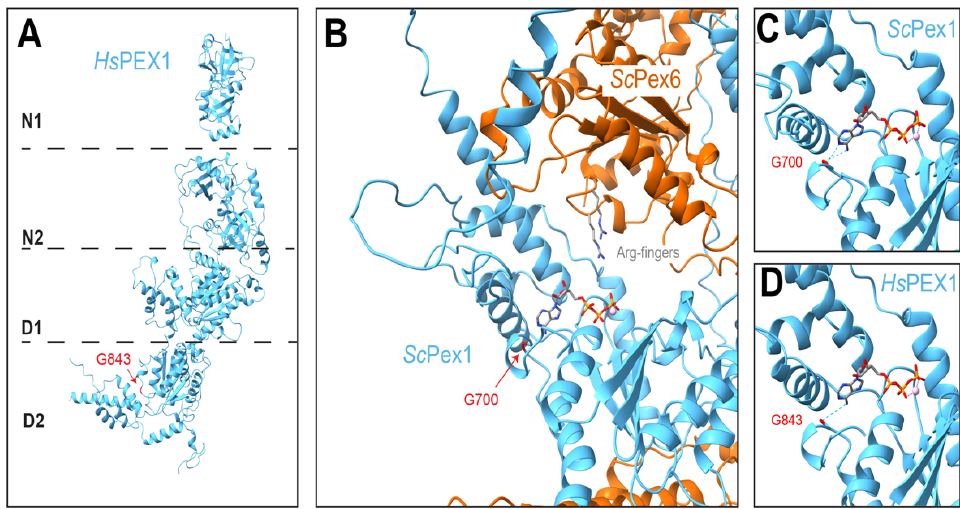
Figure 7. PEX1 G843D is expected to disrupt ATP binding and/or protomer folding. ( A ) Hs PEX1, based on AlphaFold2 and X-ray crystallography (as in Figure 2, PDB 1WLF, [148]). G843 is in the PEX1 D2 ring. ( B ) Sc Pex1 D2 ATPase in the Pex1/Pex6 hexamer at the Pex1 site most likely to be nucleotide-bound (AlphaFold2, EMDB-6359, [143]). Note that nucleotides are not discernible in experimental structures of Pex1/Pex6; an ATP is modeled based on alignment with a high-resolution structure of Hs p97 (PDB 7LN5, [159]). ( C ) The glycine G843 in Hs PEX1 is conserved. The homologous residue in Sc Pex1 (G700) is colored in red and the backbone is predicted to hydrogen bond with the adenosine of ATP ([159], ChimeraX). ( D ) In the structurally similar Sc Pex1 and HsPEX1 ATPase sites, G700 or G843 hydrogen bond (dotted lines) with ATP.